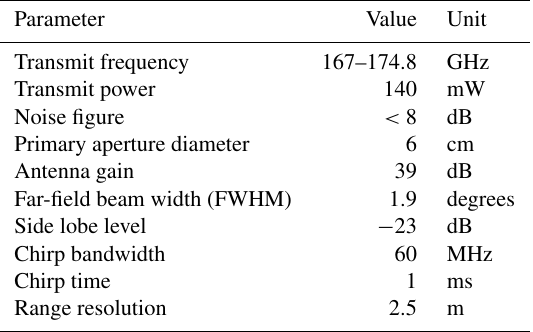
Table 1. Hardware and radar signal acquisition parameters used in this work. The noise figure reported is for a complex radar signal detected using a double-sideband front-end